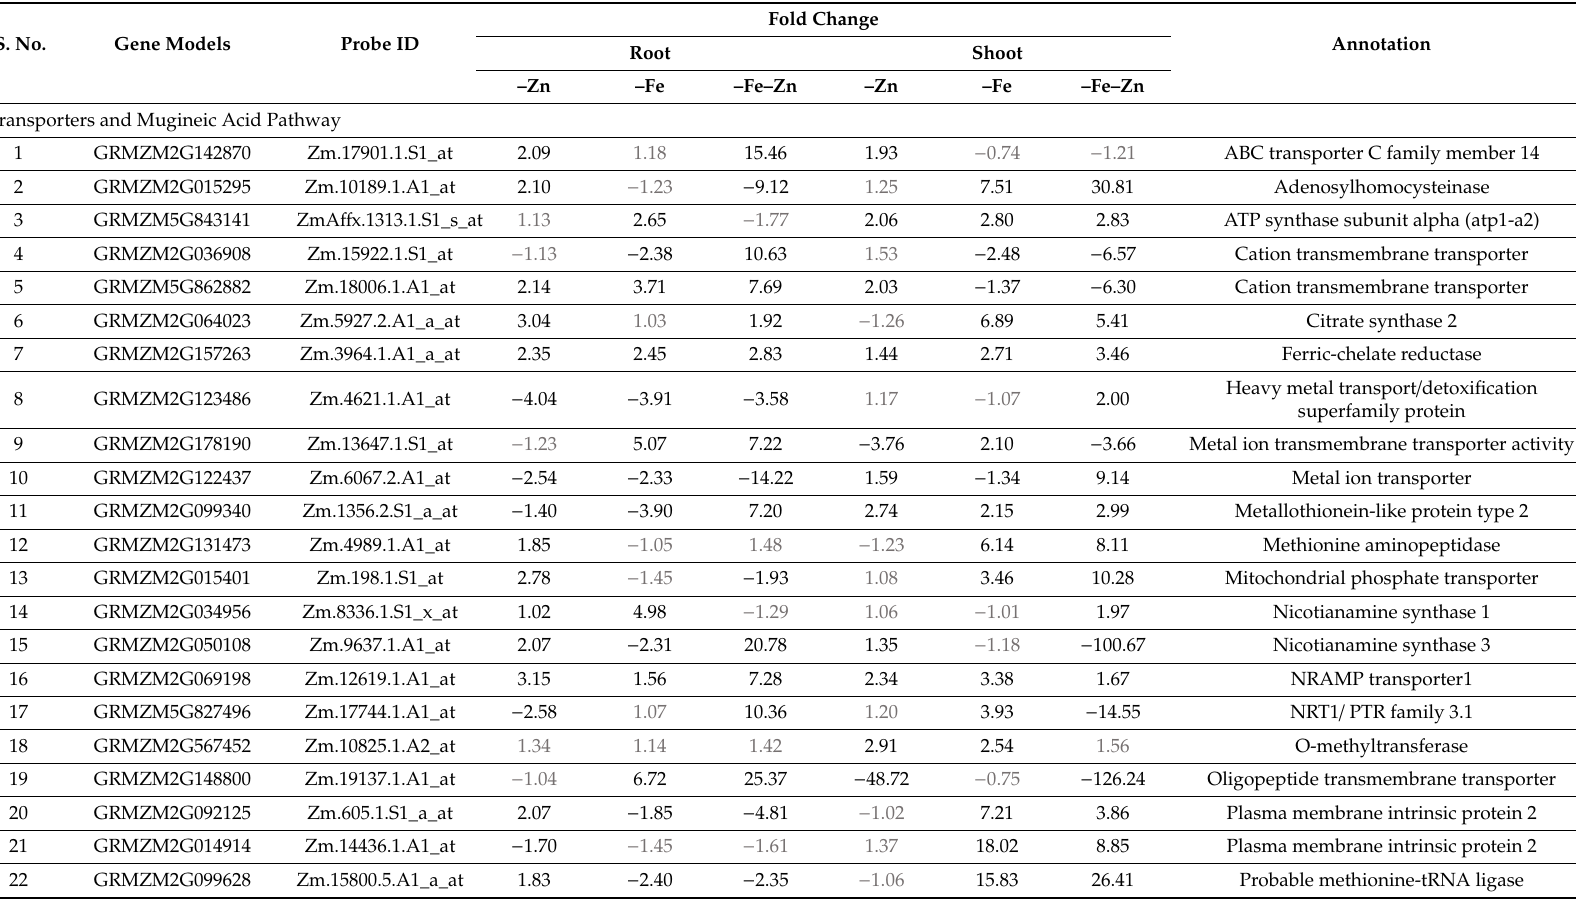
Table 1. Di ff erential expression of genes associated with the mugineic acid pathway, transporters, phytohormones, photosynthesis and carbohydrate metabolism in response to –Zn, –Fe and –Zn–Fe stresses in the root and shoot tissues. A minimum of a 2-fold change with p < 0.05 were considered for further analysis. The grey colour values indicate a non-significant p-value . Positive and negative values indicate increases and decreases in gene expression, respectively. S.